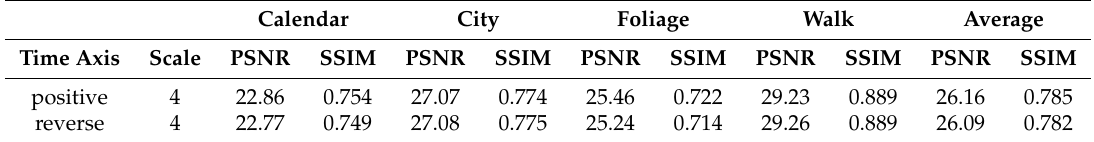
Table 1. FRVSR3-64 SR results on the positive and reverse VID4